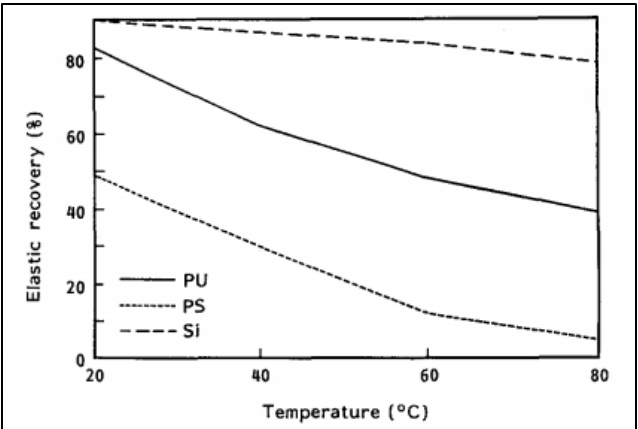
Figure 7. Influence of Elastic Recovery of the Secondary Sealant [14].